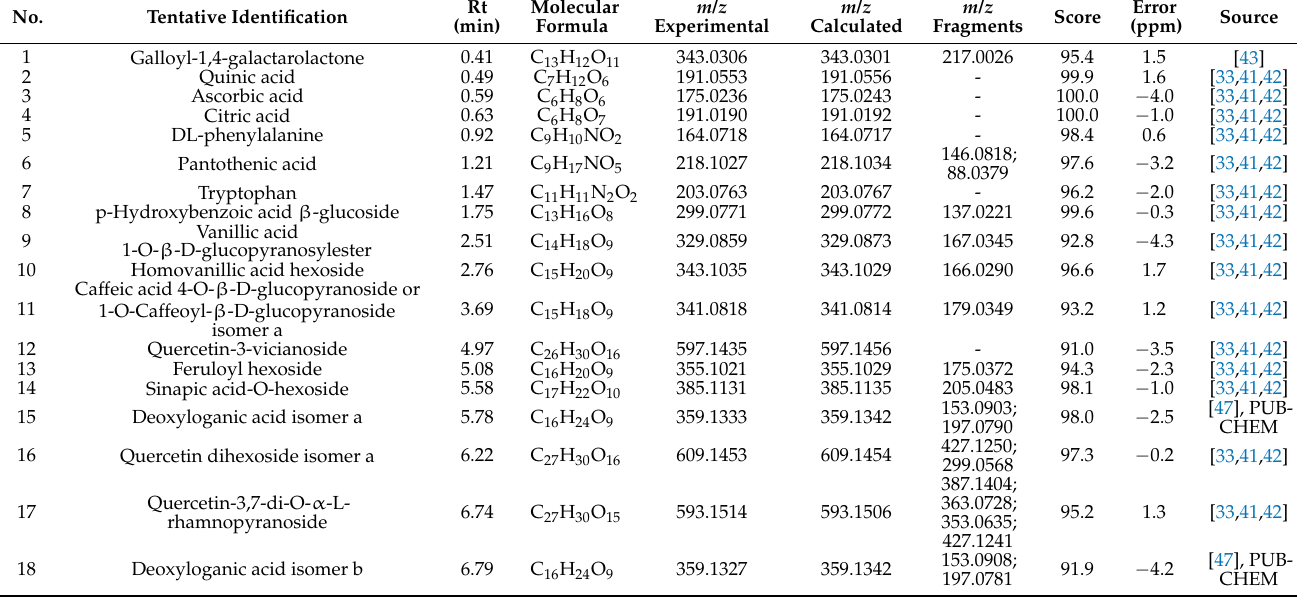
Table 6. Polar compounds tentatively identified in pepper extracts by